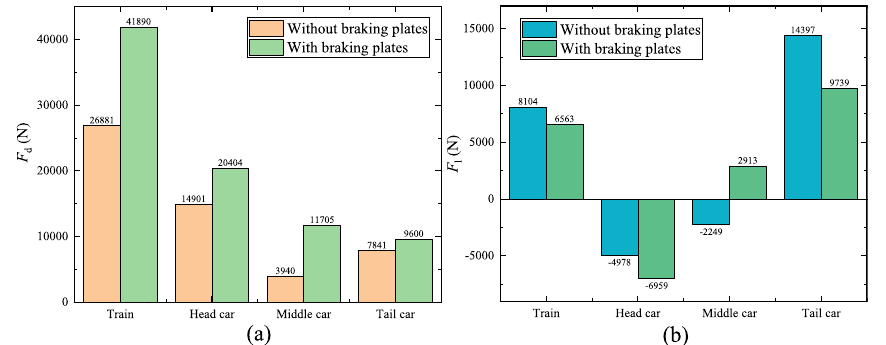
Fig. 9 The comparison results of ( a ) aerodynamic drag and ( b ) lift with or without braking plates